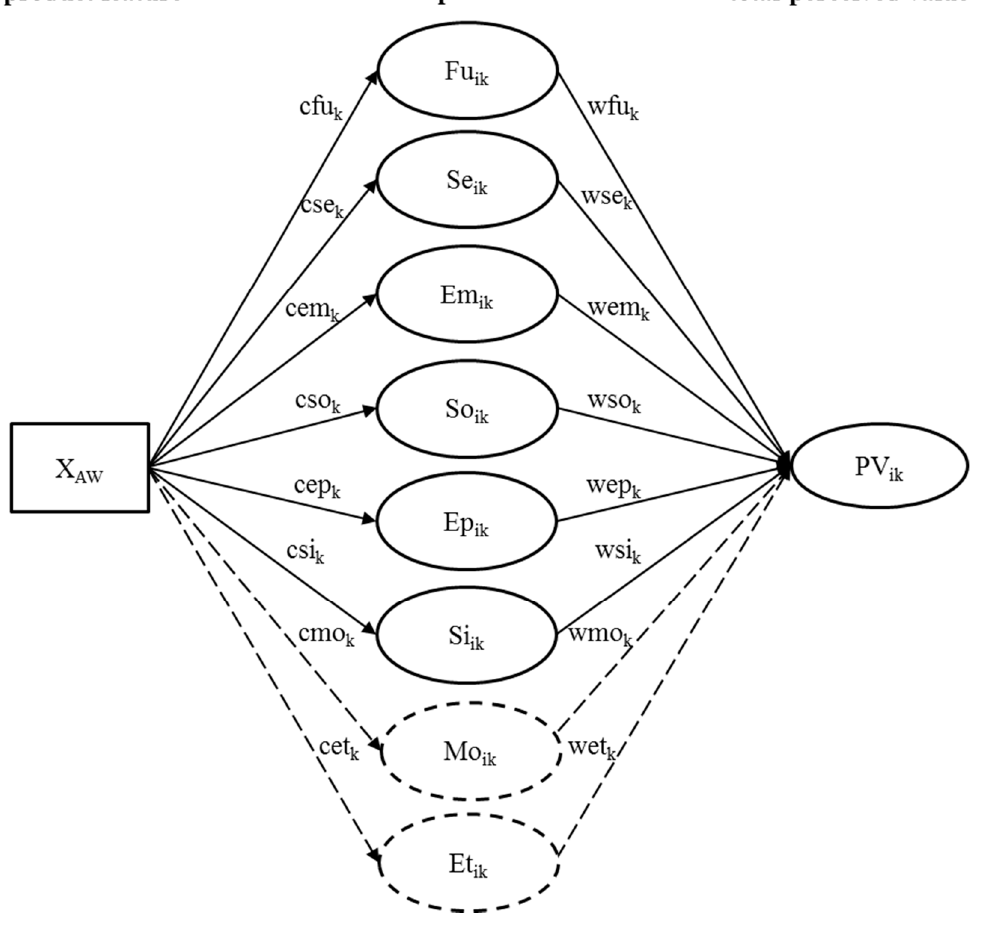
Figure 2. Reinforcement positioning strategies for animal-friendly products (adapted from [56]). The dashed arrows and constructs represent the existing associations of animal welfare with the monetary and the ethical value, which do not represent reinforcement positioning strategy.